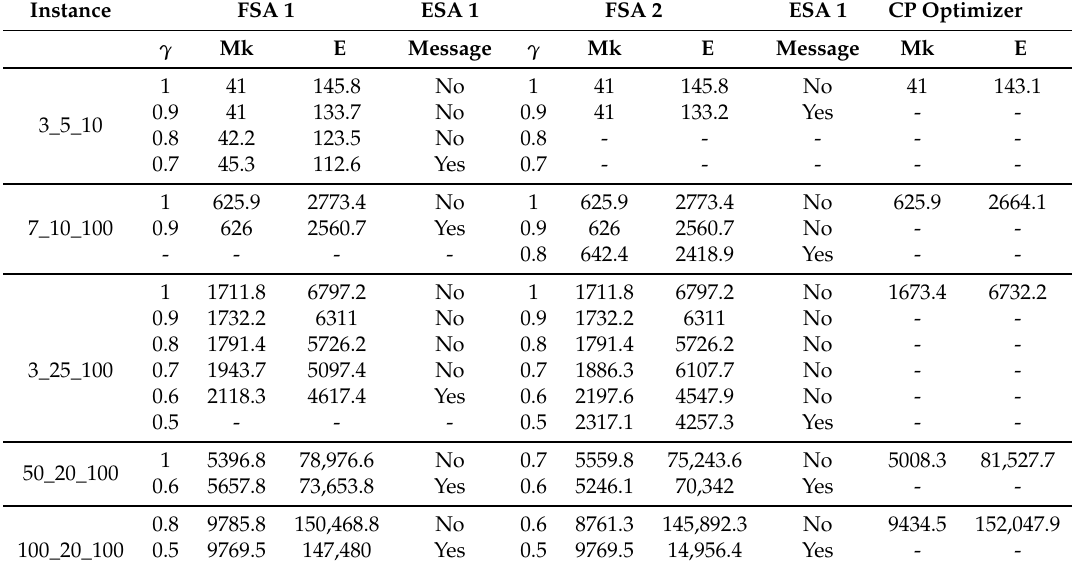
Table 2. Results of the predictive